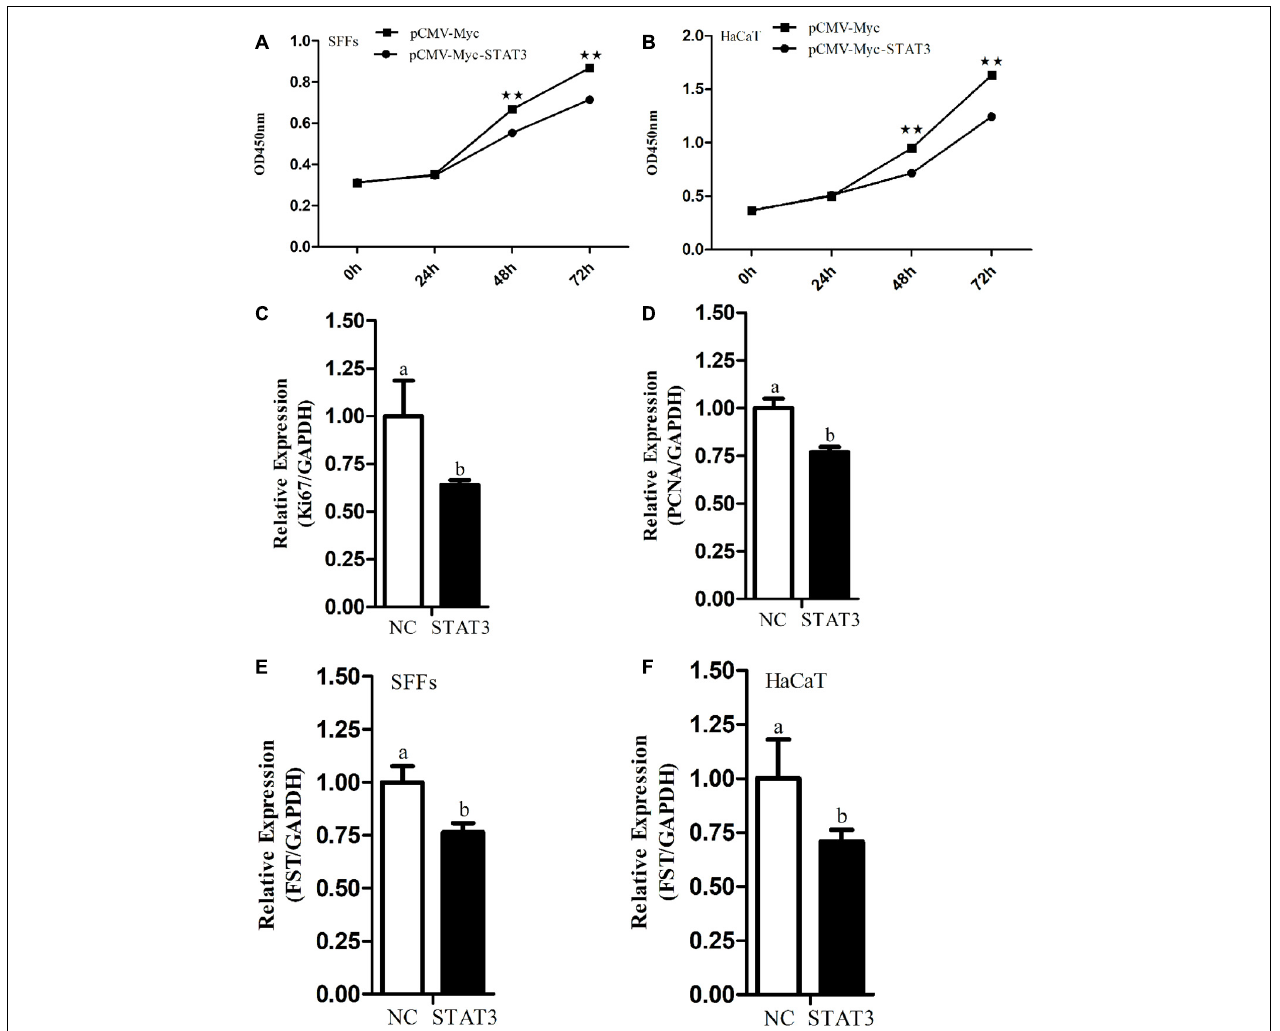
FIGURE 3 | Effects of STAT3 gene overexpression on cell proliferation and endogenous FST expression. (A,B) Effect of STAT3 overexpression on the proliferation of SFFs and HaCaT cells. (C,D) Expression levels of Ki67 and PCNA in the SFFs transfected with pCMV-Myc STAT3. (E,F) Effects of STAT3 overexpression on the endogenous expression of FST gene in SFFs and HaCaT cells. Fold change was calculated referring to the expression of the SFFs transfected with pCMV-Myc at 48 h. All data are representative of three independent experiments and display as the mean ± SEM. For each figure layer, statistical significance was indicated by * P < 0.05, ** P < 0.01, and different letters above error bars indicated a statistical significance ( P <